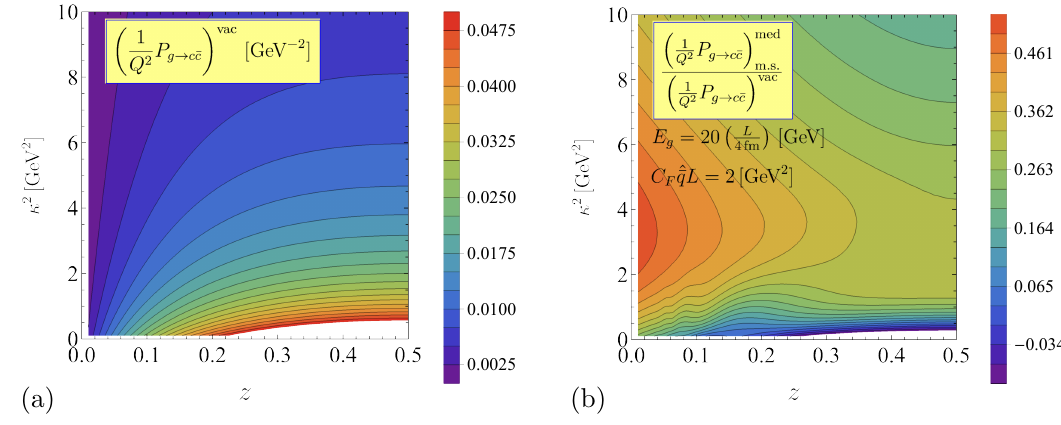
Figure 8 . (a) The vacuum splitting function (2.14) in units of GeV − 2 . (b) For an averaged squared momentum transfer ˆ qL = 2 GeV 2 from the medium, the g → c ¯ c splitting is enhanced within a wide range of intermediate transverse momentum (cid:20)